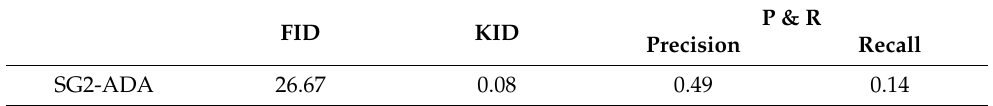
Table 2. Results of the SG2-ADA.